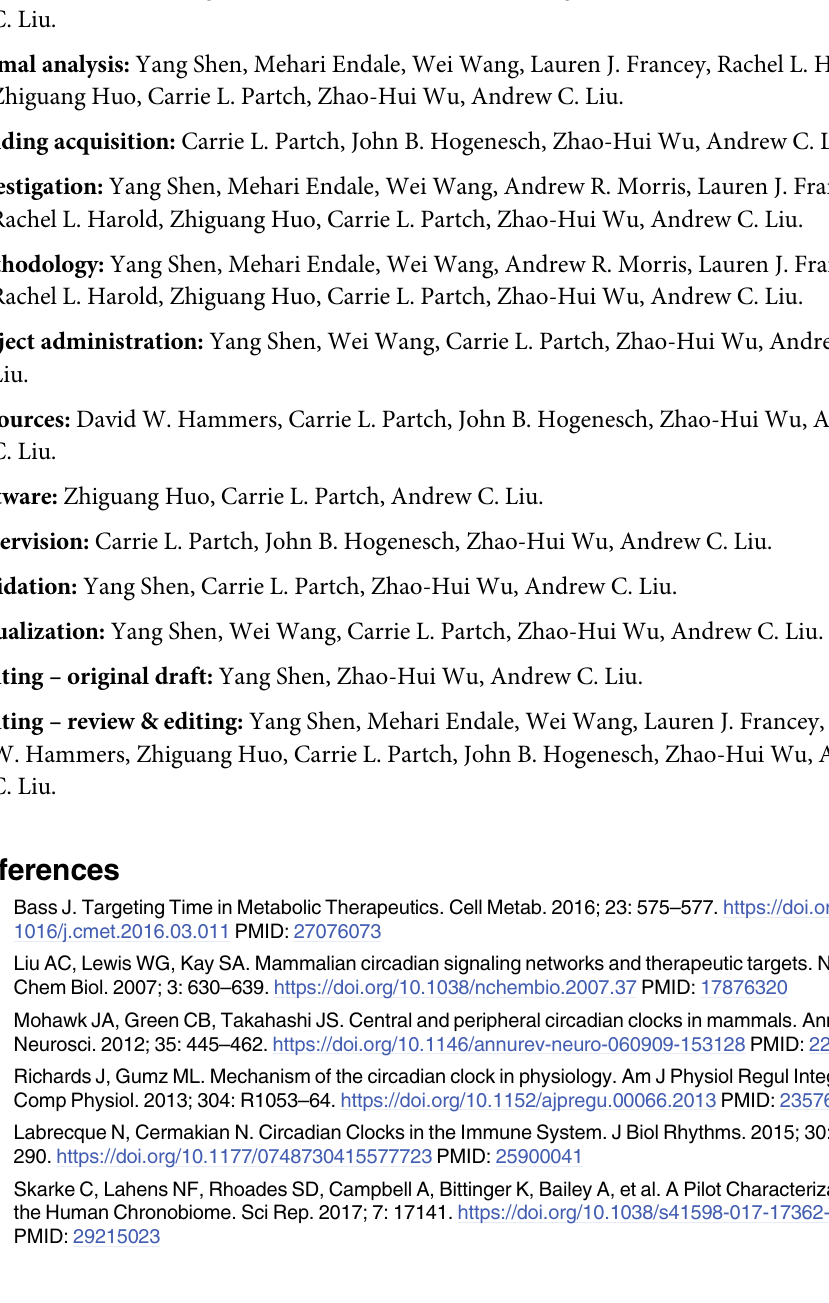
S4 Table. Probe sequences for gel